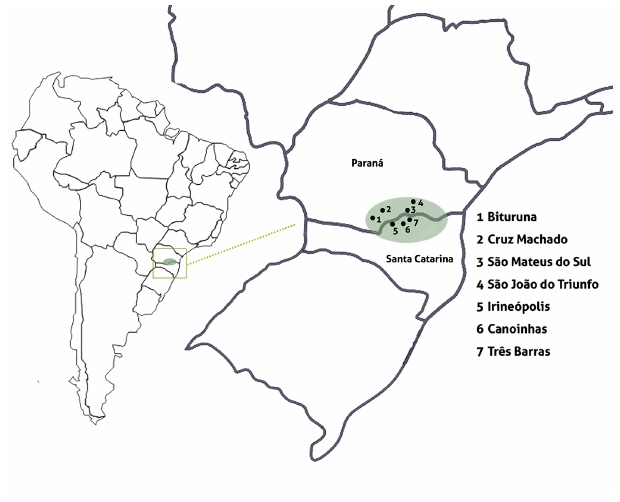
Fig. 1 . Map of Southern Brazil showing municipalities in which oral history interviews were conducted. The green circle represents the general region in which traditional erva-mate production systems continue on small-scale